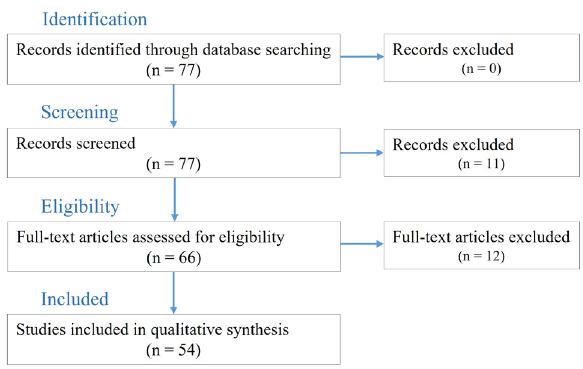
Figure 1. Flowchart process of the current review.